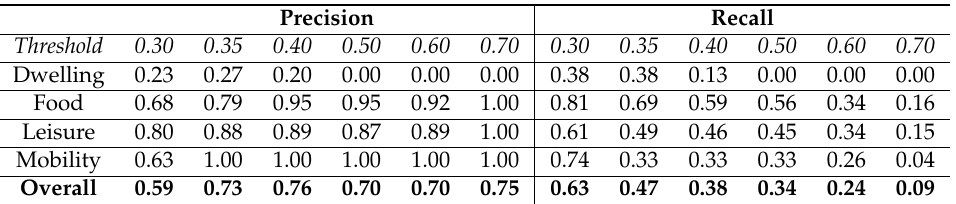
Table 8. Precision and recall values for each energy-consuming activities at varying values of threshold. The values of the precision and recall for the Dwelling category for threshold greater than 0.4 are 0 because no posts were classified in that category.